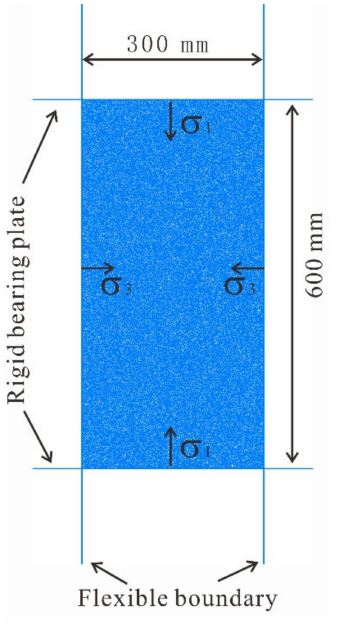
Figure 3. Schematic diagram of the biaxial test.